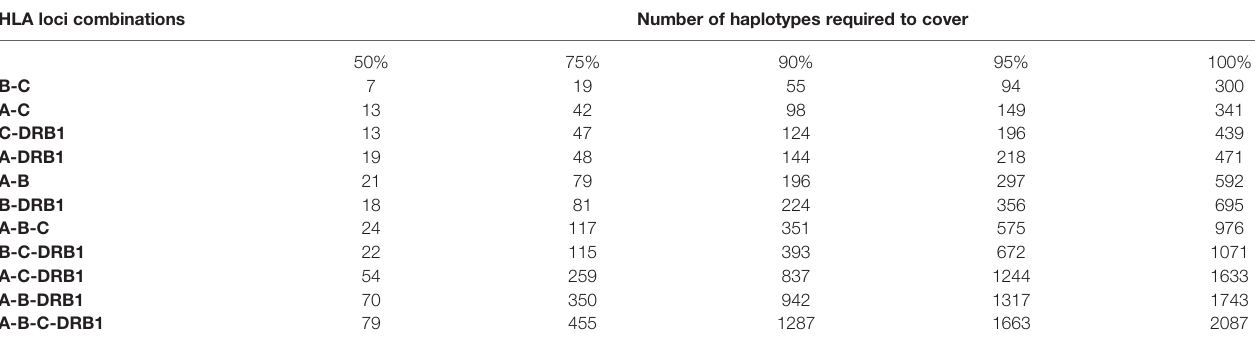
TABLE 5 | Number of the most frequent haplotypes required to cover 50%, 75%, 90%, 95%, and 100% of the genes in each locus-combination set.